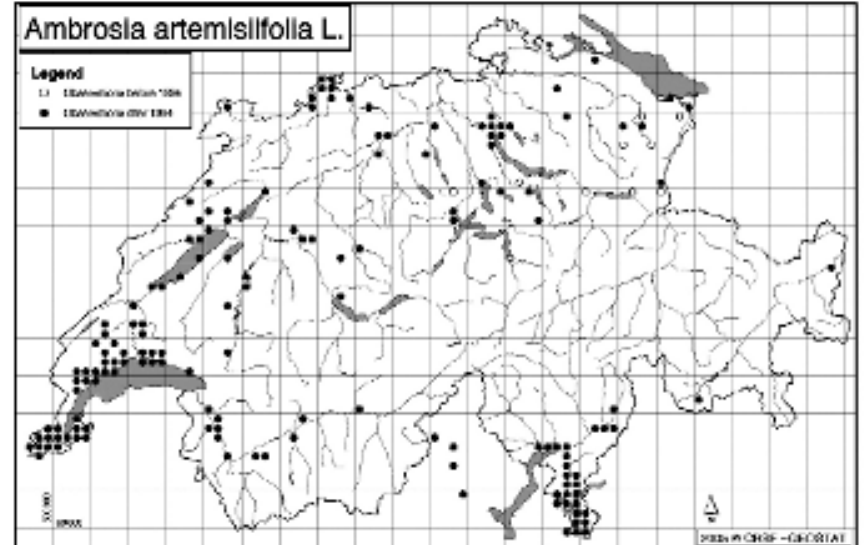
Ambrosia artemisii- folia distribution in Switzerland updated in December 2003. Elaborated by the CPS (Commission suisse pour la pro- tection des plantes sauvages) and the CRSF (Centre du réseau suisse de floristique) on a man- date of the SAEFL (Swiss Agency for Environment, Forest and